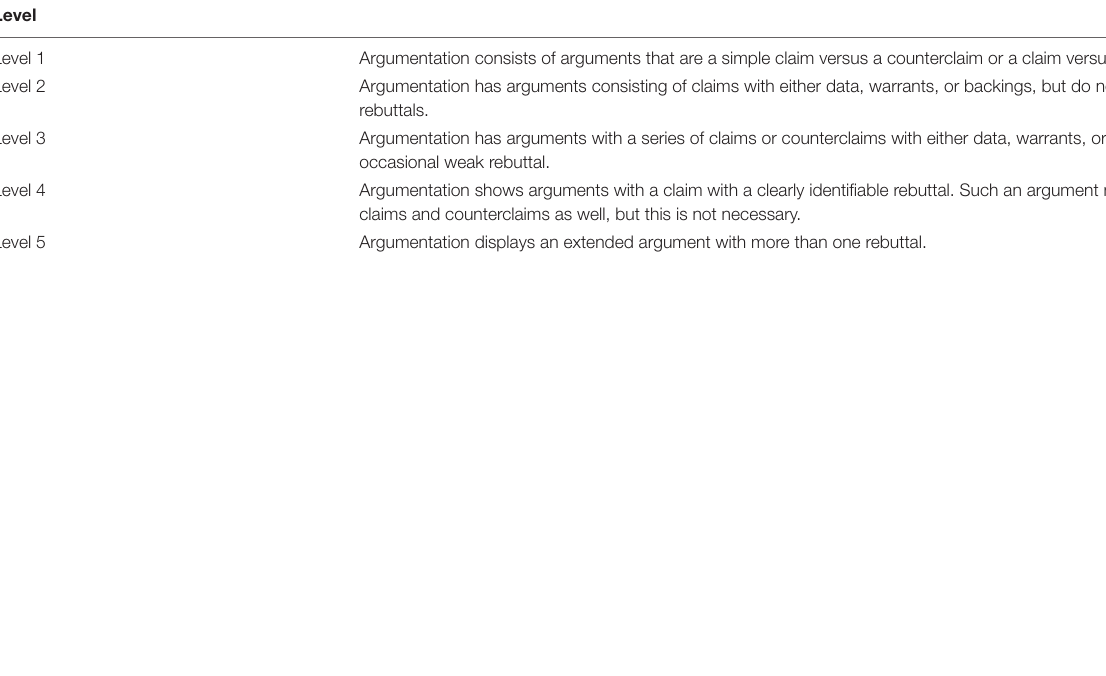
TABLE A2 | Analytical framework for assessing the quality of argumentation by Osborne et al.